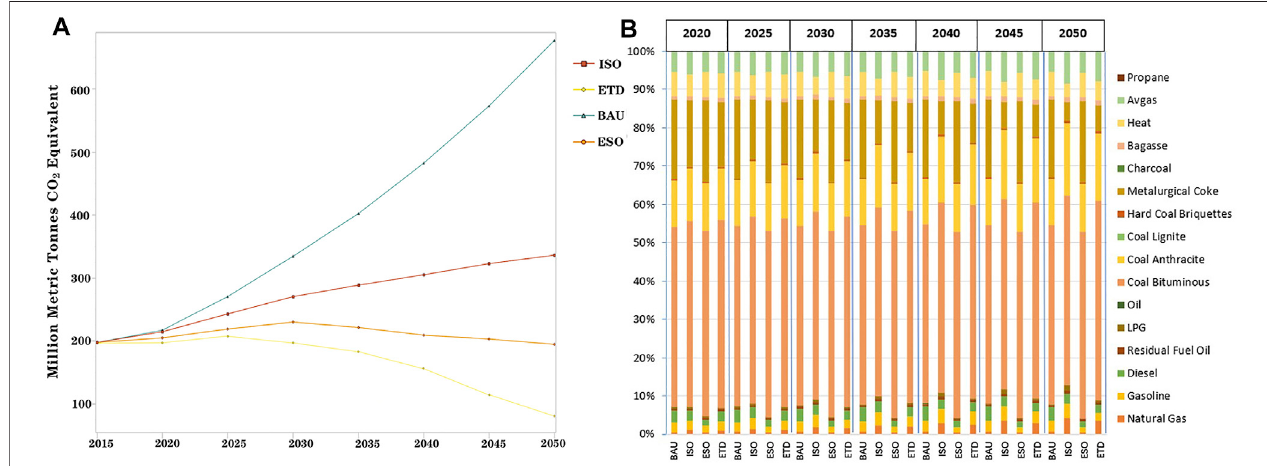
FIGURE 12 | (A) CO 2 emission of all scenarios in Suzhou and (B) share of carbon emissions by energy types and consumption